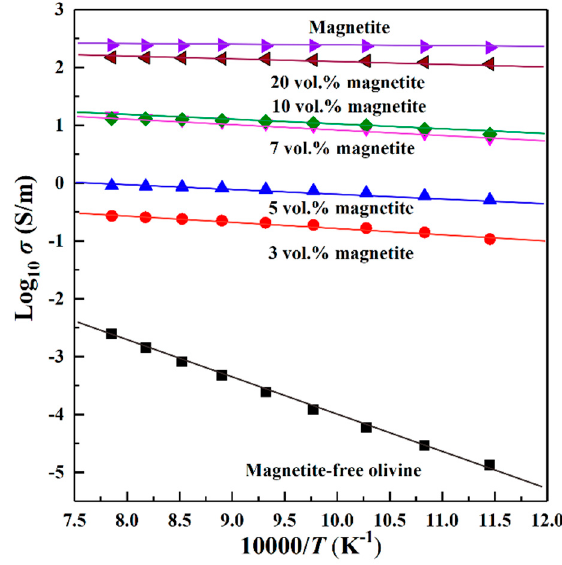
Figure 7. Effect of the magnetite volume faction on the electrical conductivity of olivine aggregates at 2.0 GPa and 873–1173 K. Table 1. Fitted parameters of the Arrhenius relation for the electrical conductivity of the magnetite- free and magnetite-bearing olivine aggregates at 1.0–3.0 GPa and 873–1273 K. Run No.